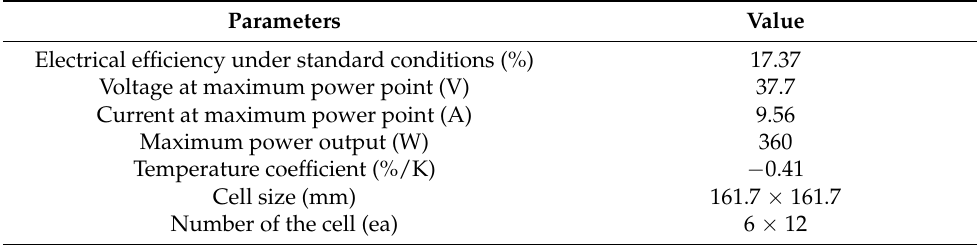
Table 1. Parameters of the PV module obtained under standard conditions (module temperature 25 ◦ C, irradiance 1000 W/m 2